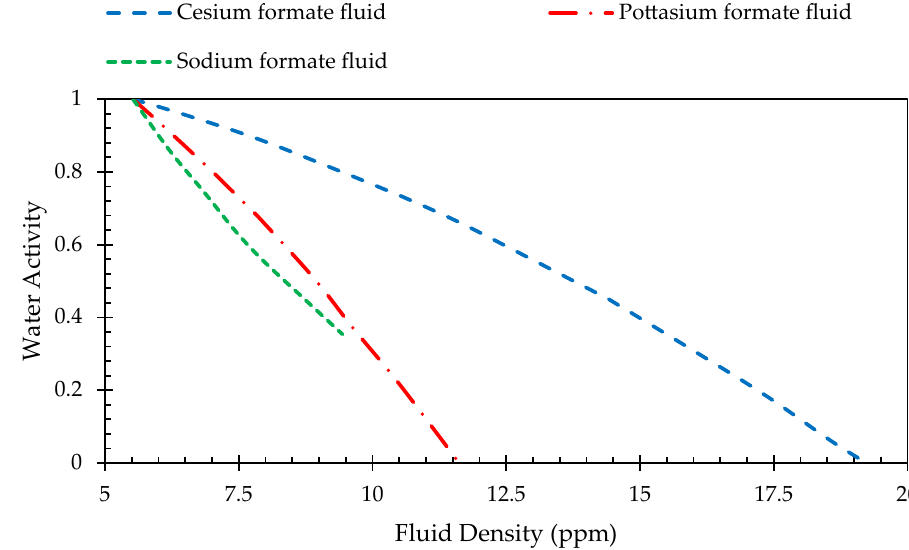
Fig. 2 Water activity for dif- ferent fluid densities of various formate